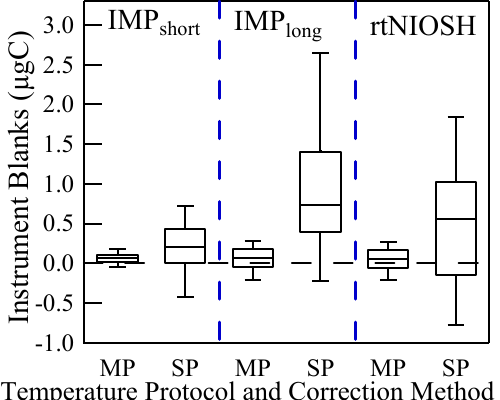
Figure 4. Instrumental blank distributions for the three protocols respectively corrected with two baseline correction methods. The box-and-stem plots depict the 5th, 25th, 50th (median), 75th, and 95th percentiles for instrumental blanks. See text for detailed explanation of the abbreviations.